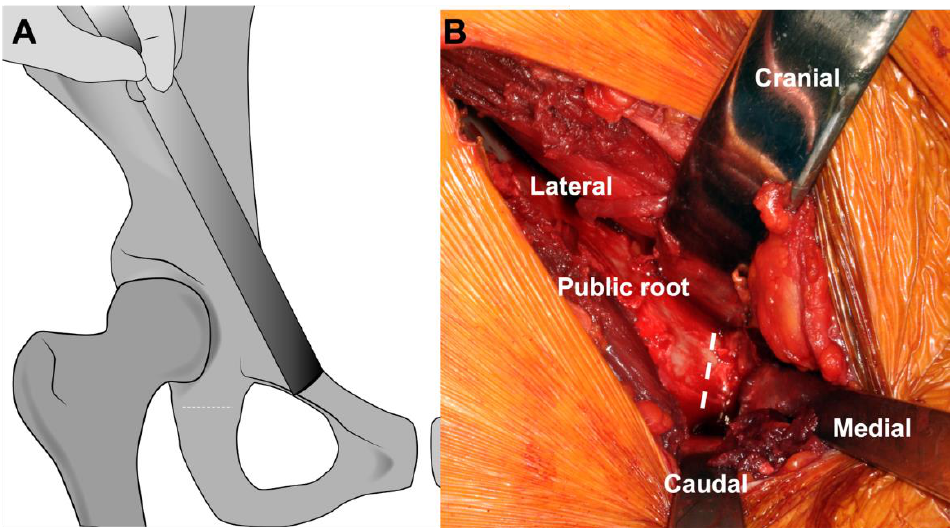
Figure 7. ( A ) Illustration showing the site of pubic osteotomy a few millimeters medial to the pubic root erring medially. ( B ) Intraoperative image showing the subperiosteal exposure of the pubic bone. The medial retractor is spiked into the pubic bone. The cranial and caudal retractors are subperiosteally inserted into the obturator foramen to protect the obturator neurovascular bundle. The dashed line shows the site of the osteotomy.